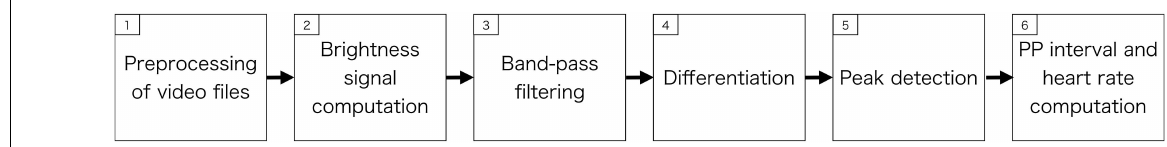
FIGURE 5 | The main processing blocks of the heart rate estimation.